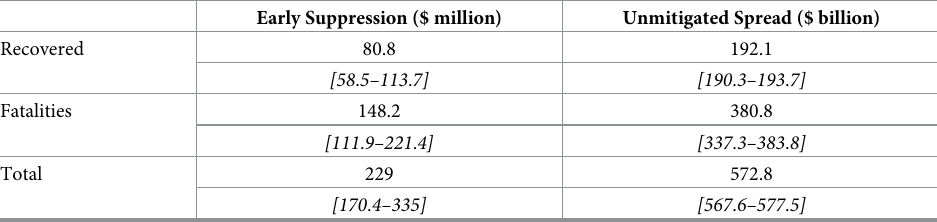
Table 2. Welfare losses of Covid-19 patients: Early versus unmitigated spread.